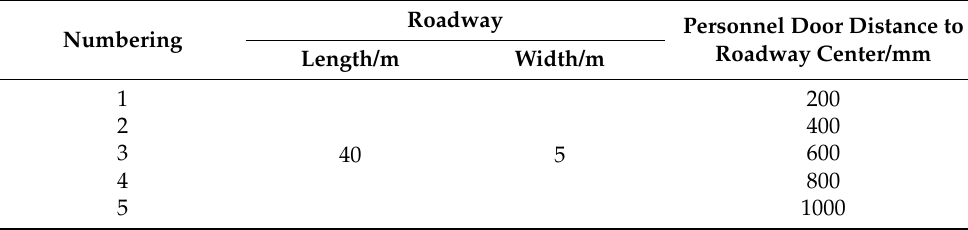
Table 5. Model size scheme.